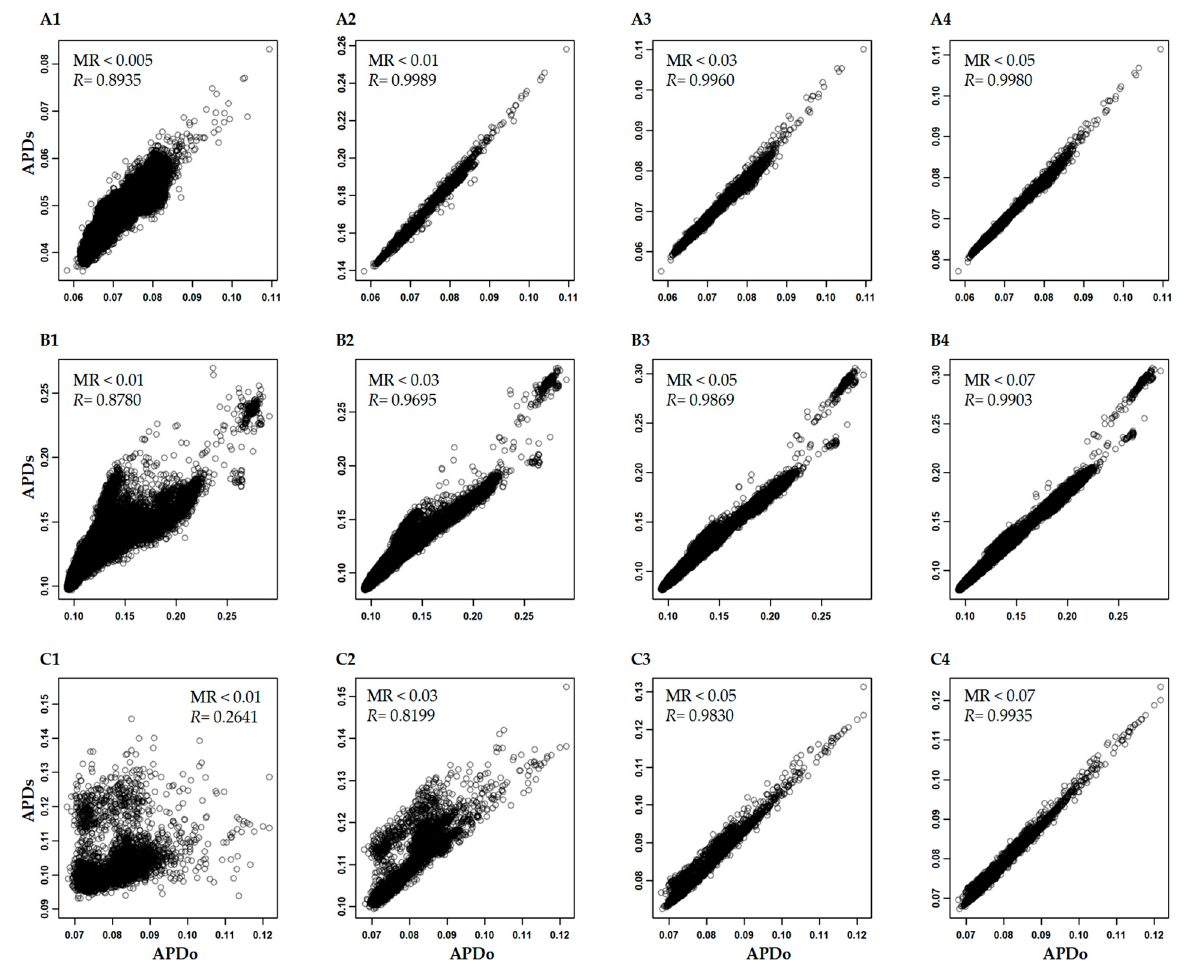
Figure 5. The correlations of APD estimates in the Hordeum vulgare ( A ), Triticum aestivum-f20k ( B ), and Cicer arietinum-f300k ( C ) data sets for all the original SNPs (APDo) and subject to removal of SNPs with missing data of rate (MR) 0.005 to 0.07 (APDs). SNPs with missing data of rate (MR) 0.005 to 0.07